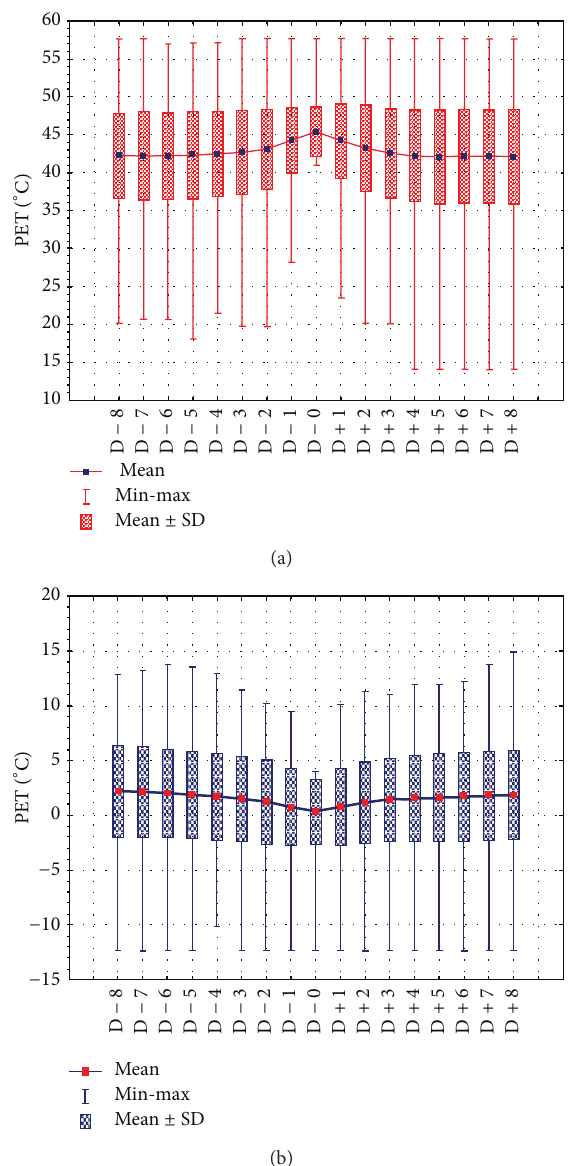
Figure 4: Superposed epoch analysis during the warm period of the year (upper graph) and during the cold period of the year (lower